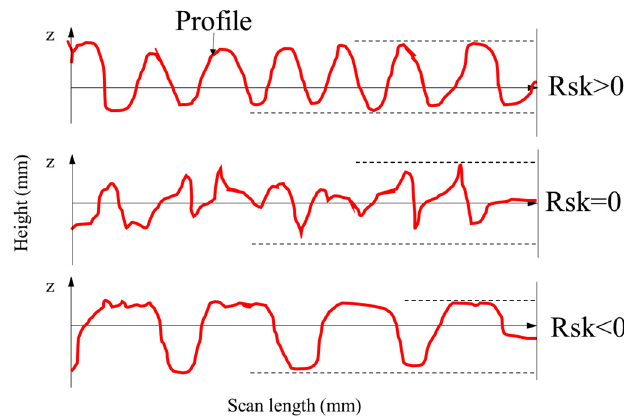
Figure 8. Schematic diagram of Rsk.